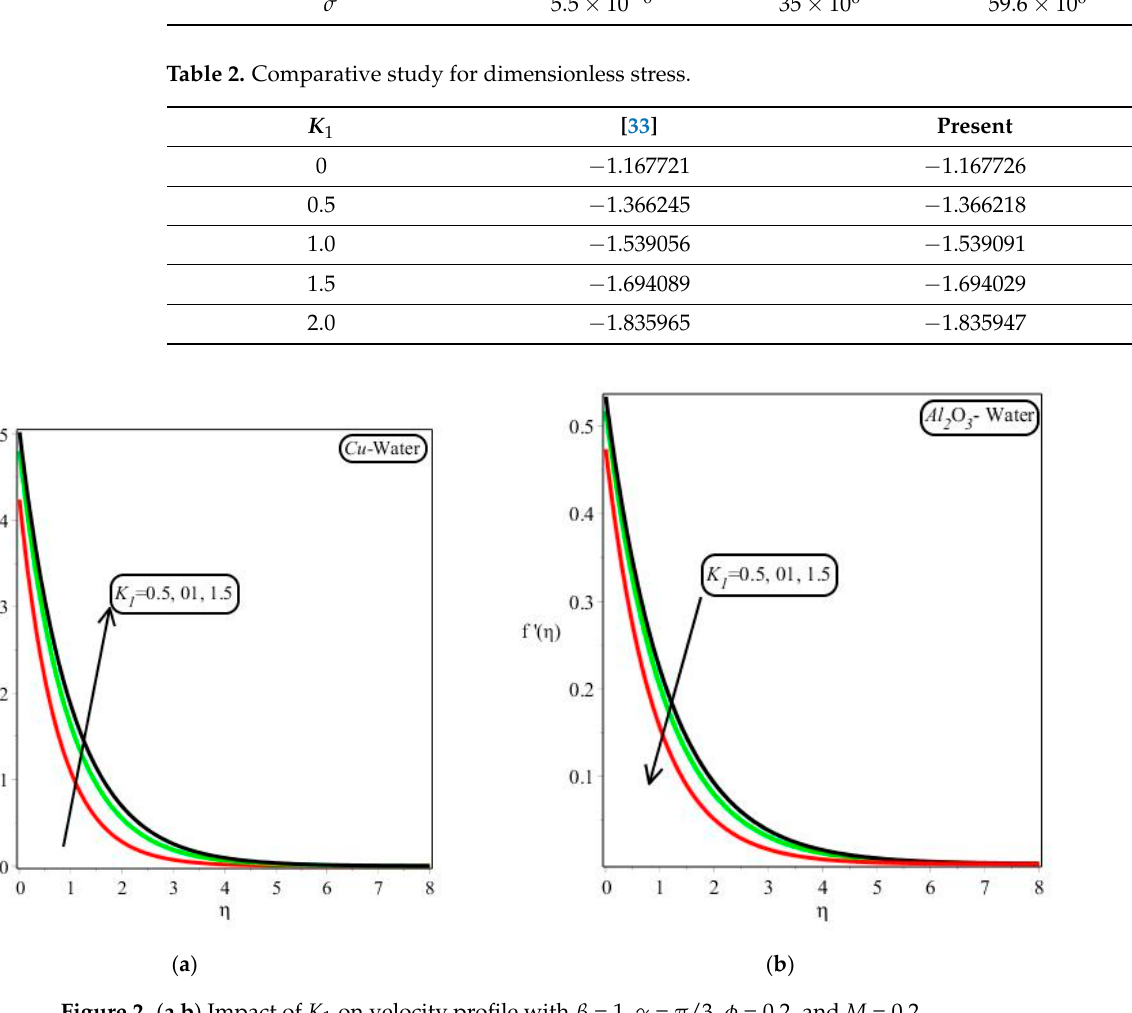
Figure 3. ( a , b ) Impact of 𝜙 on velocity profile with β = 1, γ = π /3, K 1 = 0.7, and M = 0.2.